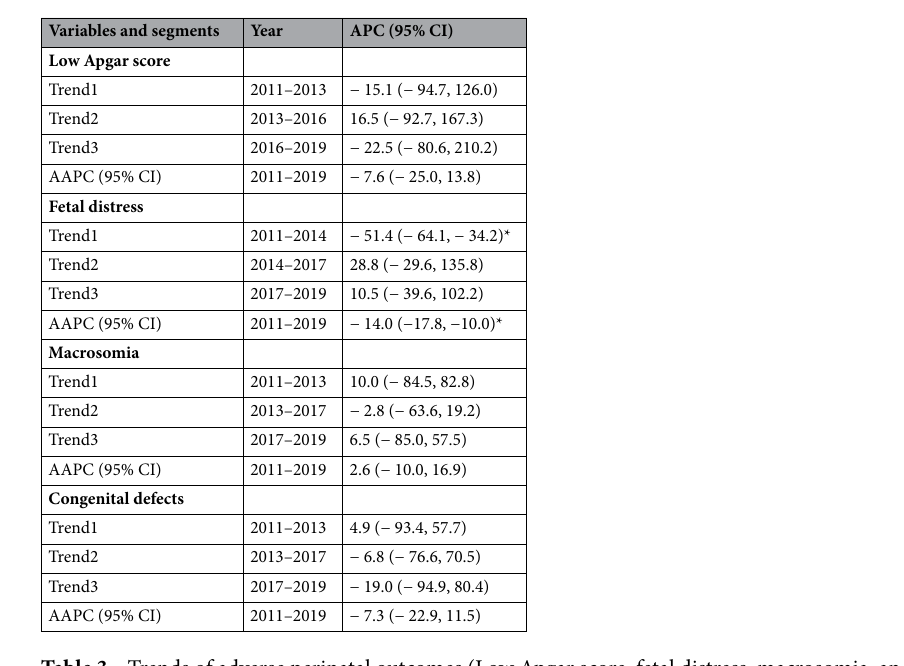
Table 3. Trends of adverse perinatal outcomes (Low Apgar score, fetal distress, macrosomia, and congenital defects) using joinpoint regression analysis from 2011–2019. APC annual percentage change, APPC average annual percent change, CI confidence interval. *Significantly different from 0 at alpha = 0.05 ( p <